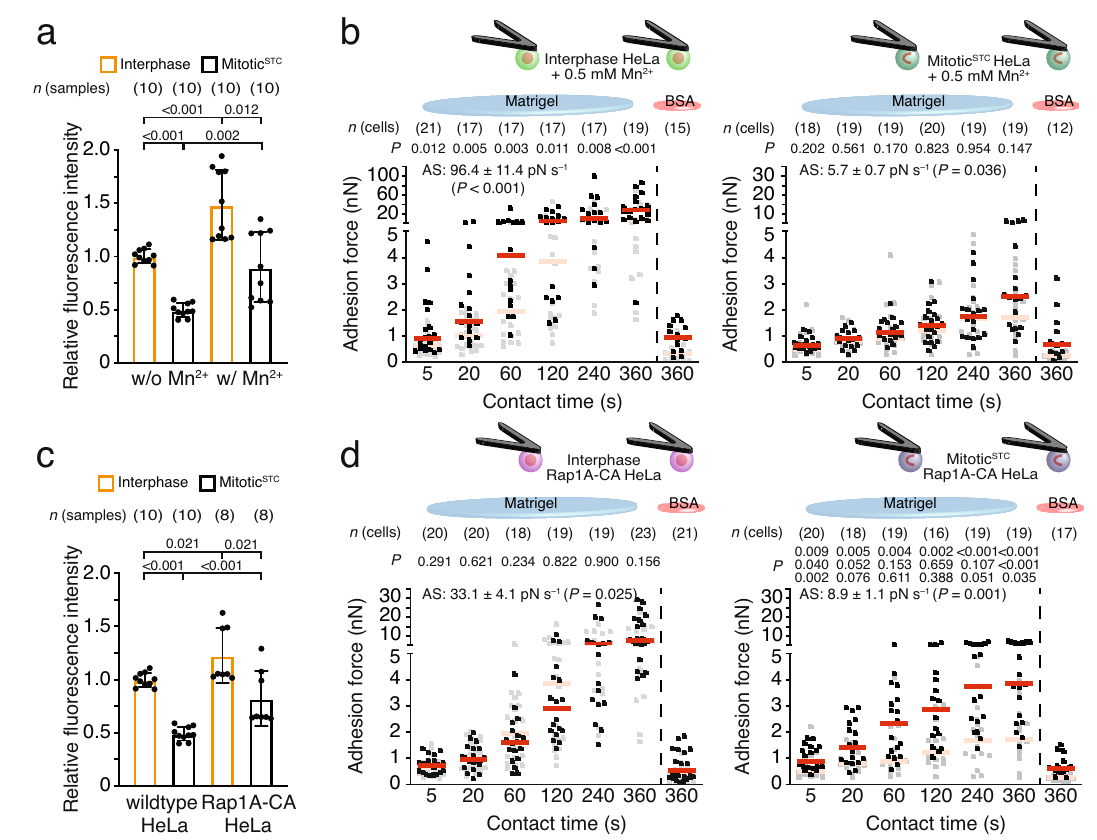
Fig. 5 | Expression of constitutively-active Rap1A increases mitotic cell – ECM adhesion strengthening. a Fluorescence intensity of untreated (Fig. 2b) or Mn 2+ - treated HeLa cells labeled for extended β 1 integrins (clone 9EG7). Dots represent median fl uorescence intensities of 20,000 cells normalized to the mean median fl uorescence intensity of untreated interphase HeLa cells, bars the mean of all normalized medians, and error barstheir SEM. n (samples) indicates the number of biological independent samples tested. b Adhesion forces of interphase (left) or mitotic STC (right) HeLa cells incubated with 0.5mM Mn 2+ to Matrigel or BSA after given contact times. Adhesion forces of untreatedinterphase or mitotic HeLacells to Matrigel or BSA are given asreference in gray (Fig. 1a). Dots represent adhesion forcesofsinglecells,redbarstheirmedianand n (cells)thenumberofindependent cells in at least three independent experiments. AS-values give the adhesion strengthening rate as the slope (±SE) of a linear fi t through adhesion forces for all